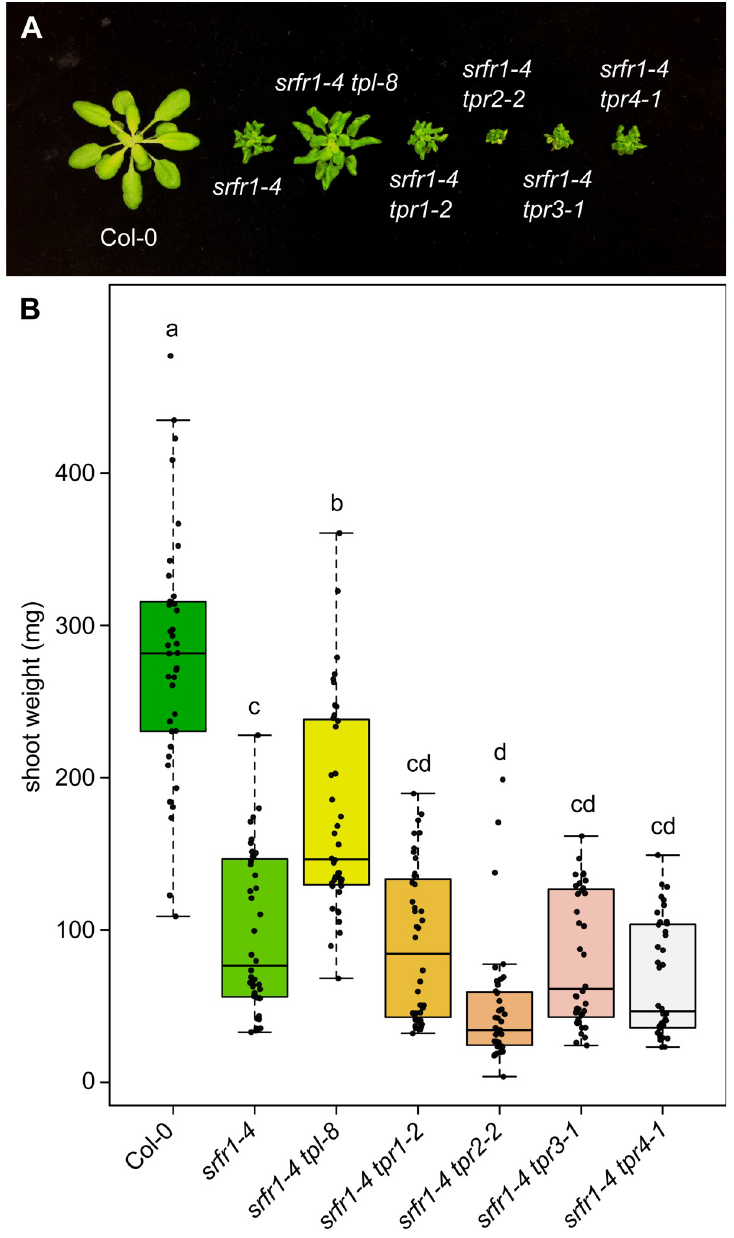
Fig 1. Loss of function of TPR2 increases stunting in srfr1 . (A) Morphological phenotype of srfr1-4 and srfr1-4 tpl/ tpr double mutants at four weeks post sowing. (B) Shoot weight from plants grown under short day conditions at 21˚C for four weeks. Dots represent individual data points taken over two separate experiments. Whiskers on boxplots are drawn to the farthest data point within 1.5 � IQR of first and third quartiles. Letters denote significant differences as determined by Student’s t-test ( P < 0.01) using the Bonferroni-Holm method to correct for multiple